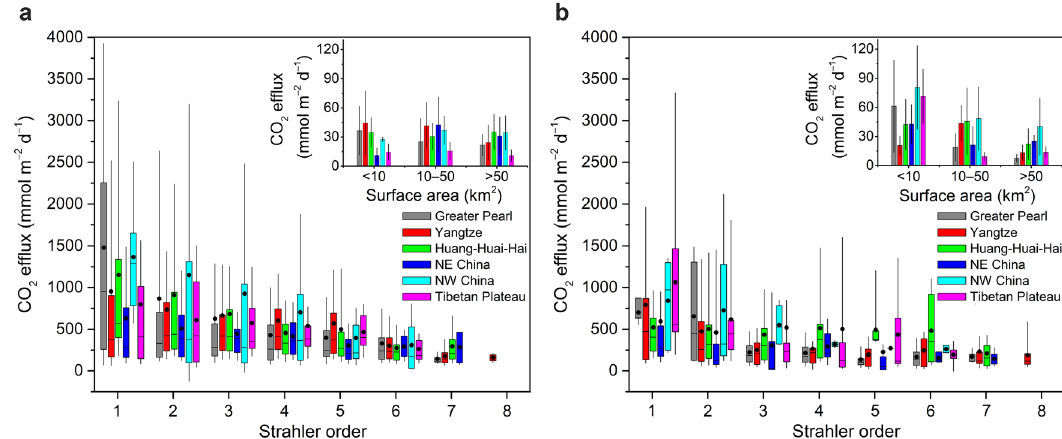
Fig. 2 Spatial distribution of CO 2 ef fl uxes across Strahler orders of Chinese stream network. a 1980s. b 2010s. The box spans the interquartile range, the circle denotes the mean, the line denotes the median and the whiskers represent the 10th and 90th percentiles. Also shown in the inset graph are CO 2 ef fl uxes from lakes and reservoirs in the 1980s (a) and 2010s (b) for comparison. Error bars represent mean ± standard